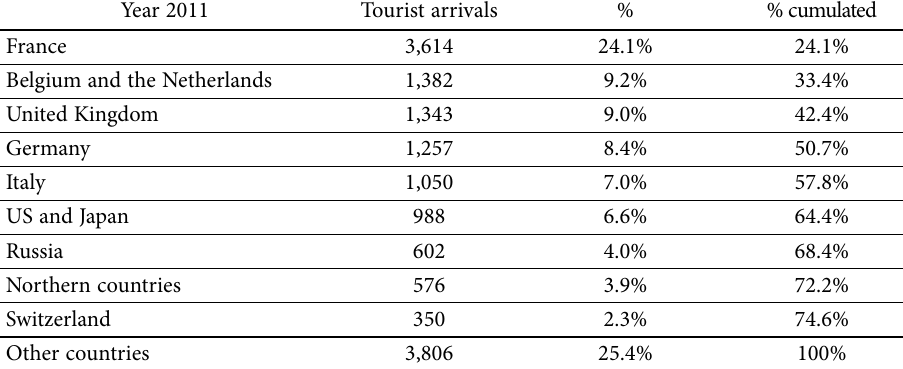
Table 2. Distribution of the frequency of tourist